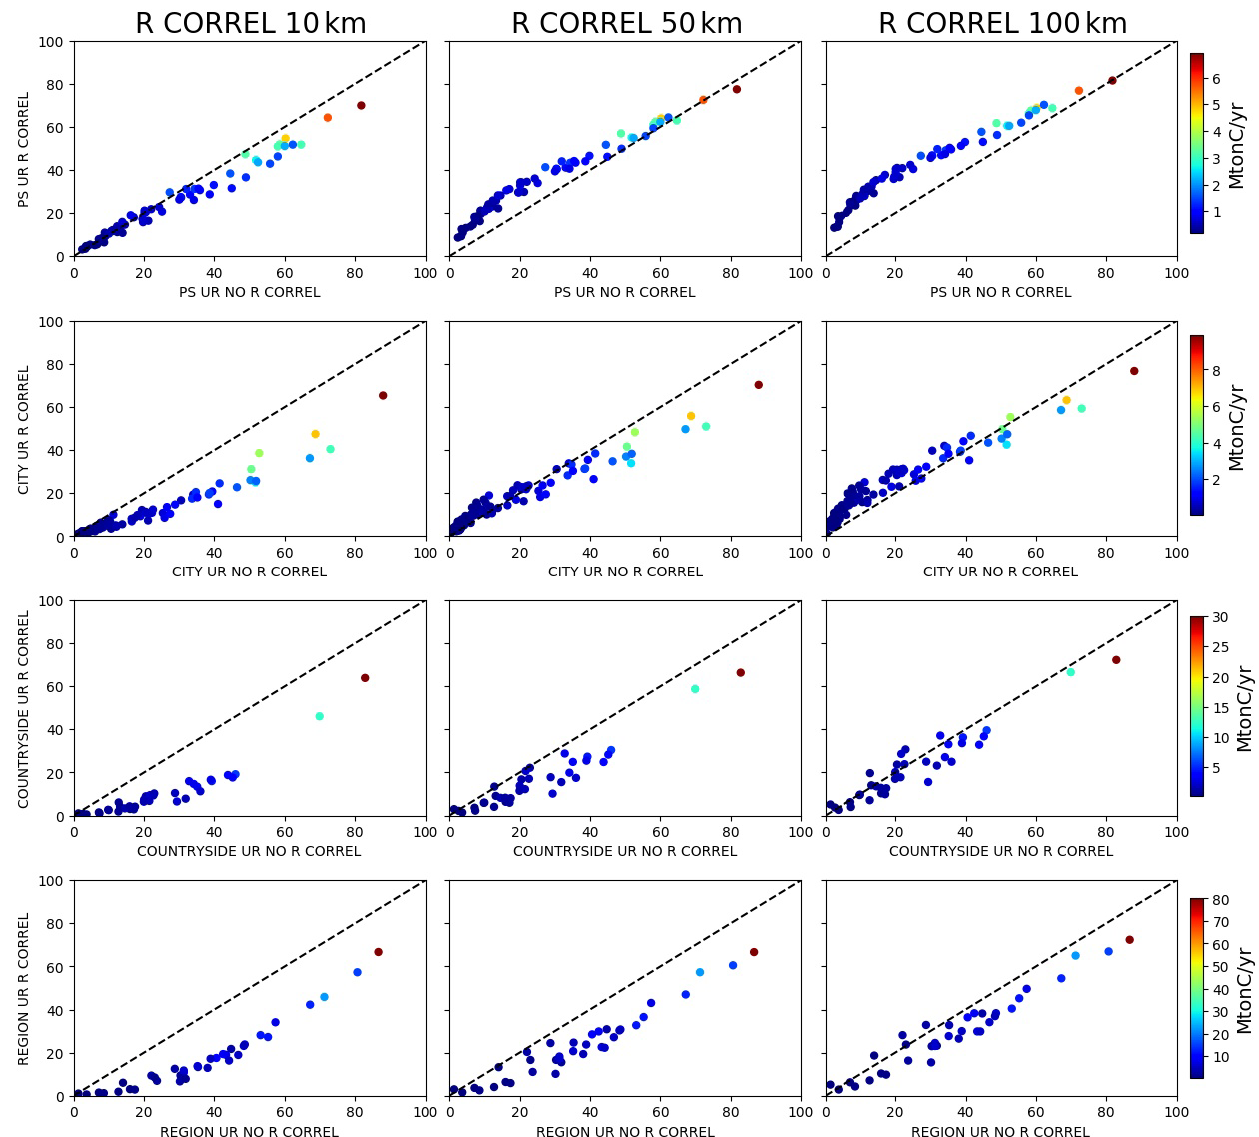
Figure A3. Uncertainty reductions (UR) for the emissions of the point sources (first row), the urban areas (second row), the countryside areas (third row) and the regions (fourth row) when considering spatial correlations ( y axis) or no correlations ( x axis) between the observation errors. The first, second and third columns correspond to correlations with a spatial scale of 10, 50 and 100km, respectively. The colors of the dots correspond to the annual budgets of the sources (color bar on the right of the figure). The dashed line is the 1 : 1